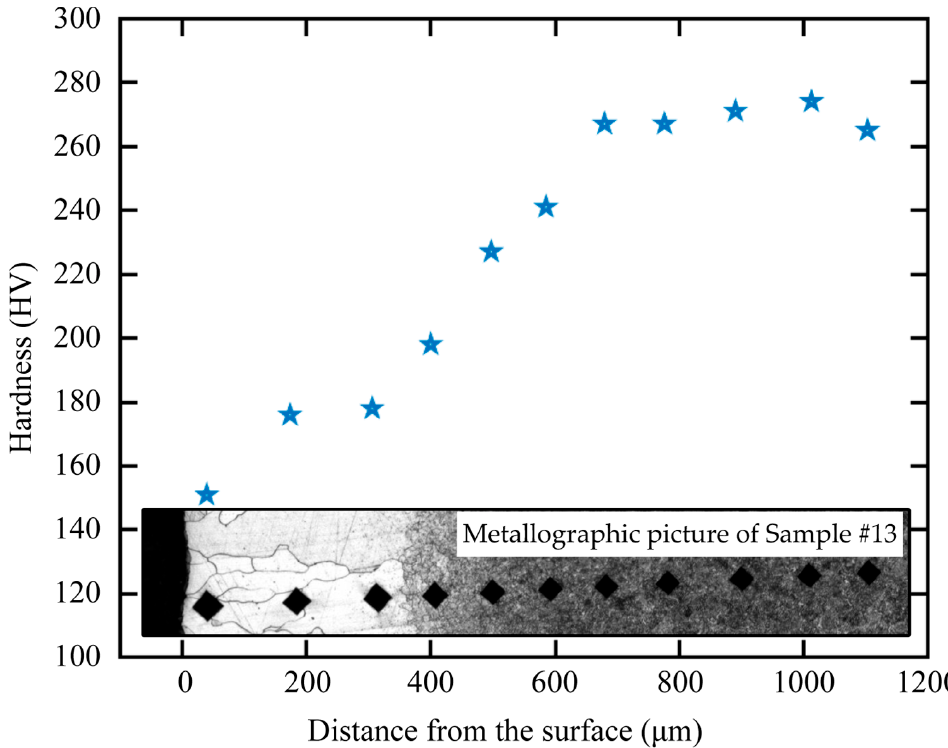
Figure 5. Hardness profiles and metallographic picture of the steel sample with a pearlitic core austenitized for 6 h (Sample 13#).